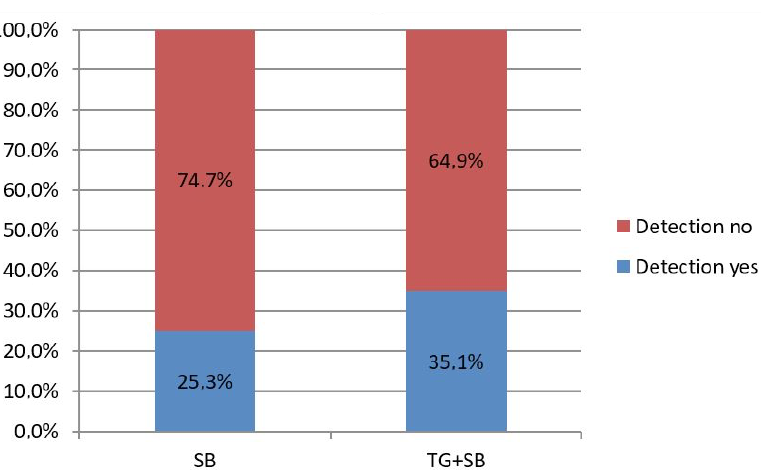
Fig. 1. Comparison of systematic biopsy (SB) against targeted and systematic bi- opsy (TG+SB) in the repeated biopsy group in the detection of clinically significant prostate cancer ( P =0.047).